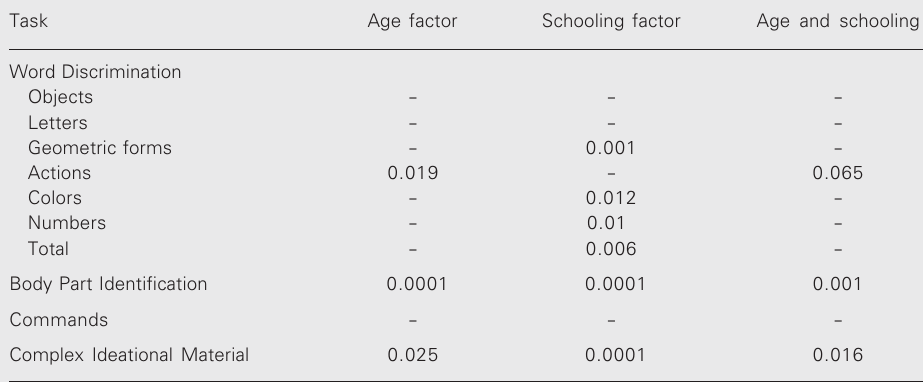
Table 5. MANOVA results for each task considering age and schooling